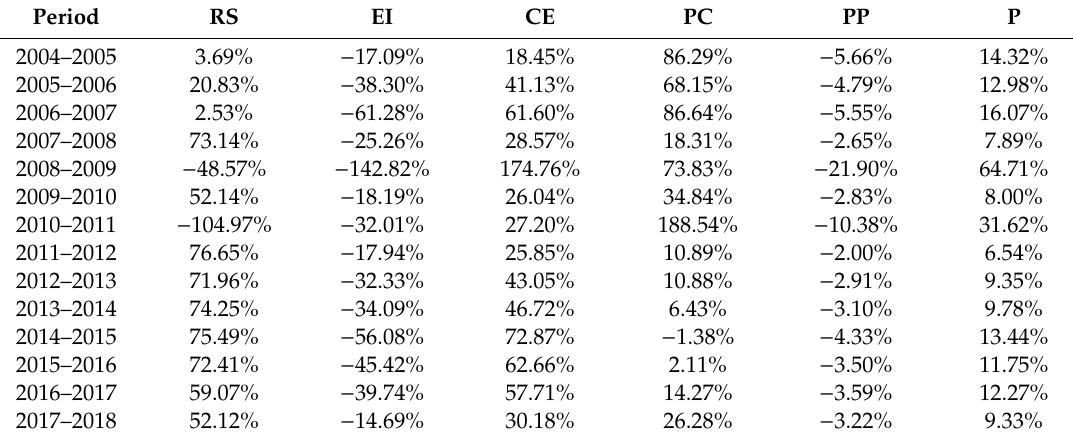
Table 4. Contribution rate of each factor.